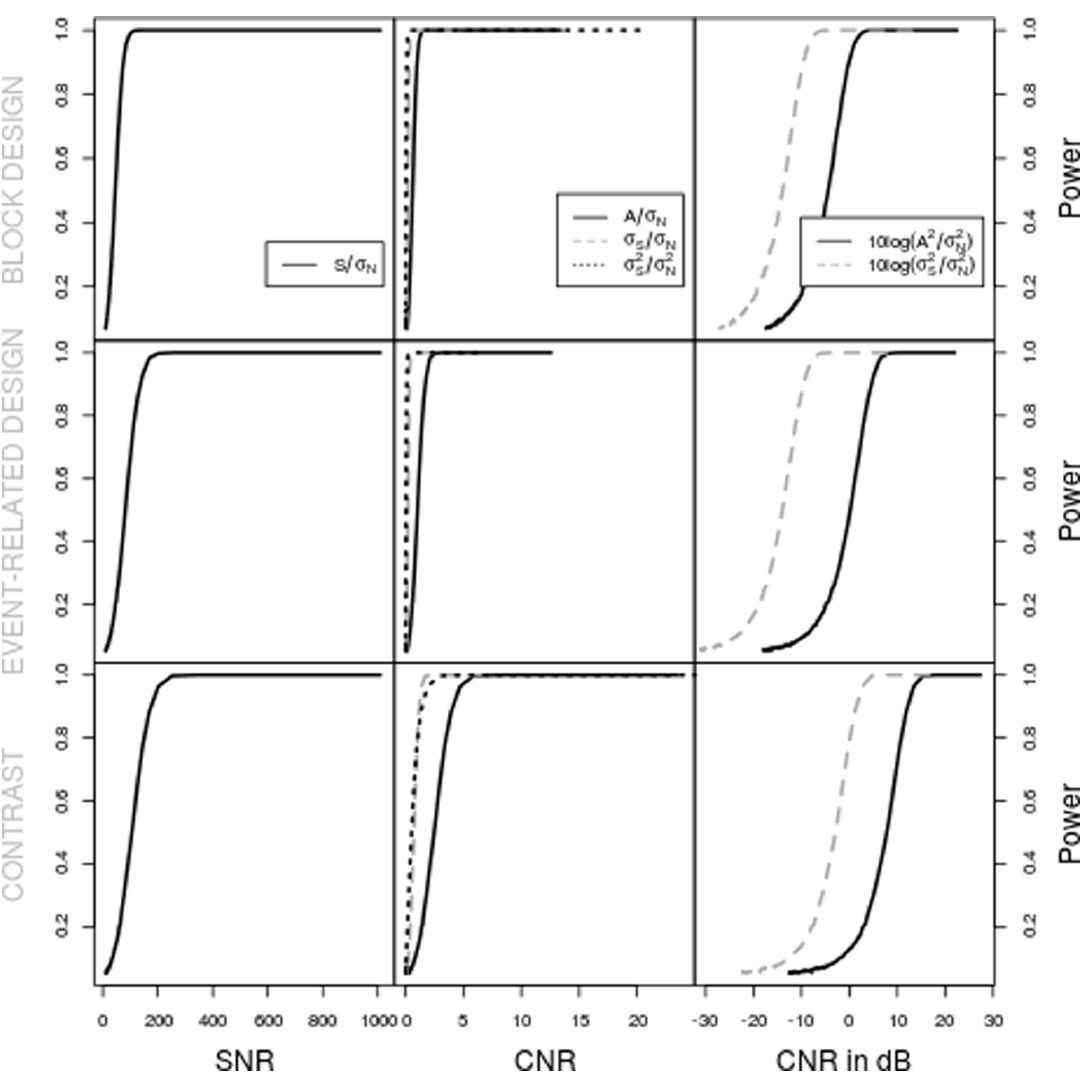
Figure 4. The relationship between power and the SNR/CNR definitions for 1% signal change.